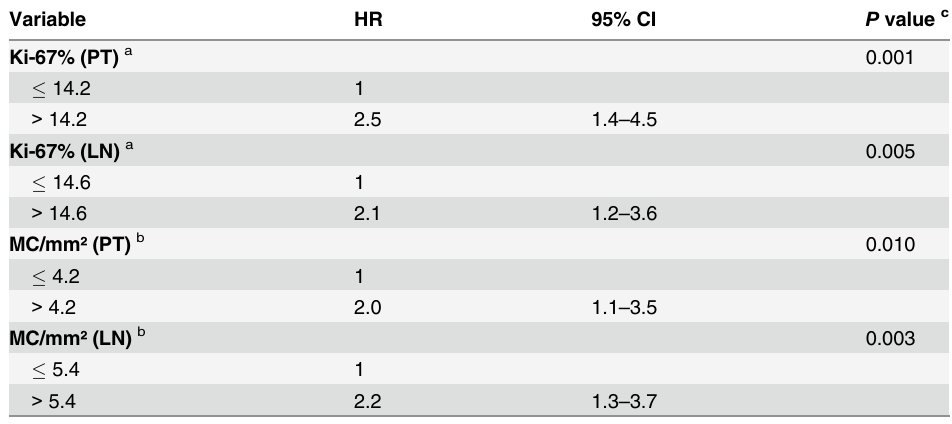
Table 4. Univariate survival analysis of proliferation markers examined in lymph node metastases ( n = 168).